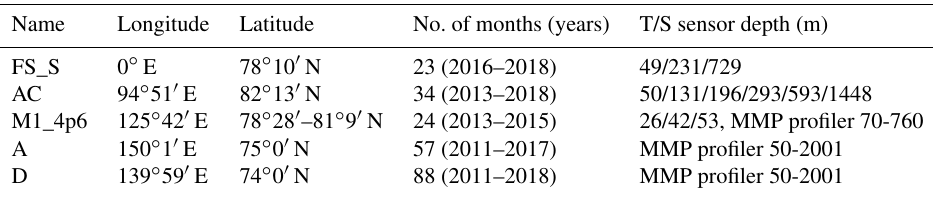
Table 1. Names, locations, monthly data availability and temperature/salinity sensor depth for the seafloor moorings used as a comparison dataset to validate altimetry-derived η (cid:48) (refer to Fig. 9).